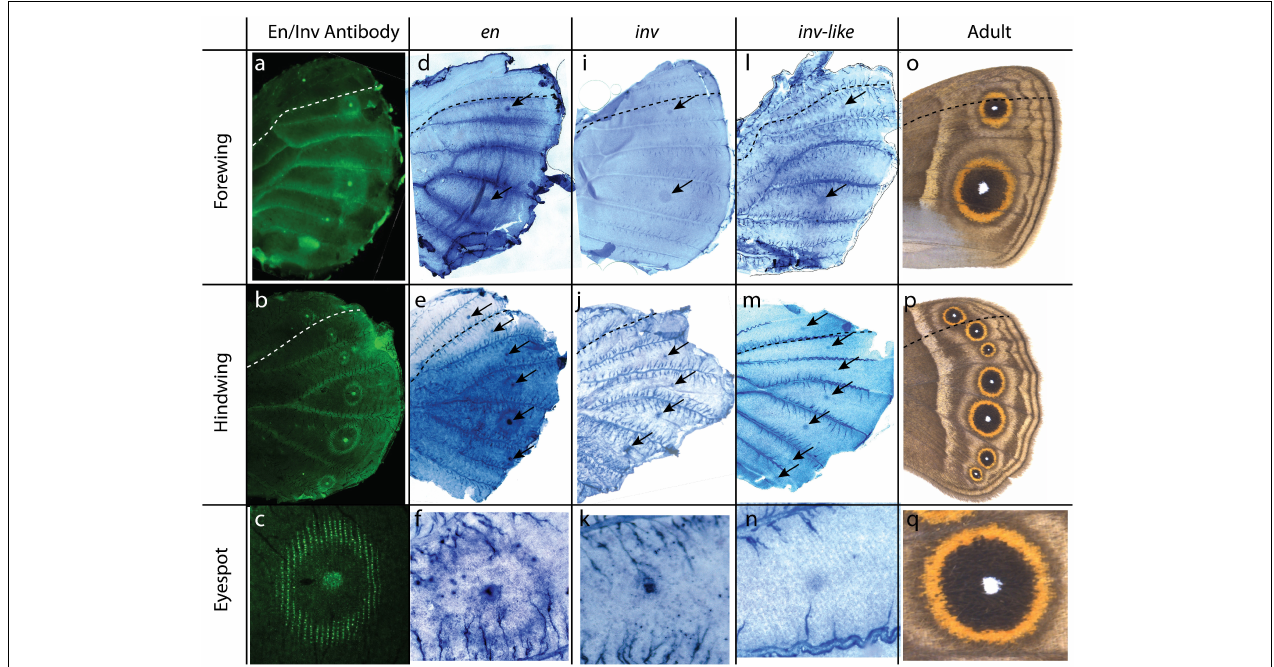
FIGURE 3 | Expression of en , inv , and inv-like in B. anynana butterflies’ pupal wings. (a–c) Antibody staining of En-like proteins using 4F11 antibody, En-family proteins are present in the posterior compartment, eyespot centers, and golden rings; (a) forewing, (b) hindwing, (c) eyespots. (d–f) In situ hybridization of en using a specific probe. en is expressed in the posterior compartment of each wing, eyespot centers, and golden rings; (d) forewing, (e) hindwing, (f) eyespots. (i–k) In situ hybridization of inv using a specific probe. inv is expressed in eyespot centers; (i) forewing, (j) hindwing, (k) eyespots. (l–n) In situ hybridization of inv-like using a specific probe. inv-like is expressed in the eyespot centers. (m) forewing, (n) hindwing, (o) eyespots. (o–q) Adult phenotype. Anterior and posterior compartment are separated by dotted lines. Black arrows point to the eyespot centers. The staining in the veins and side trachea (as in panel n ) are non-specific stains also observed with control probes (sense probes; Supplementary Figures S1d–f,j–l,p,q